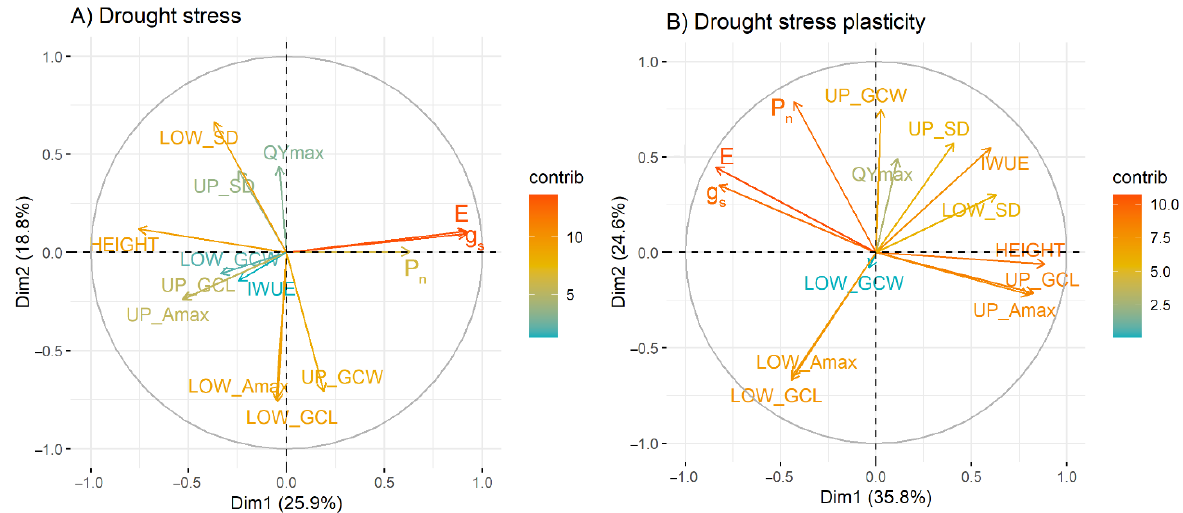
Figure 2. Trait loading scores of the physiological and stomatal traits for each principal component under two conditions; ( A ) drought stress and ( B ) drought stress plasticity.